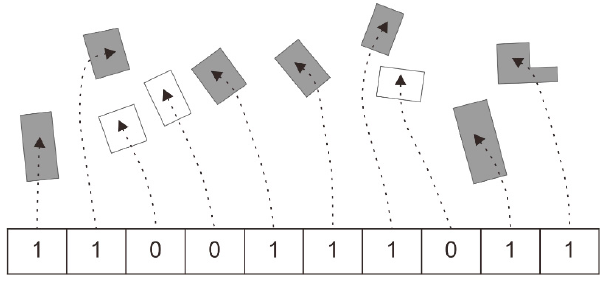
Figure 3. Binary encoding for the selection problem of 10 buildings.